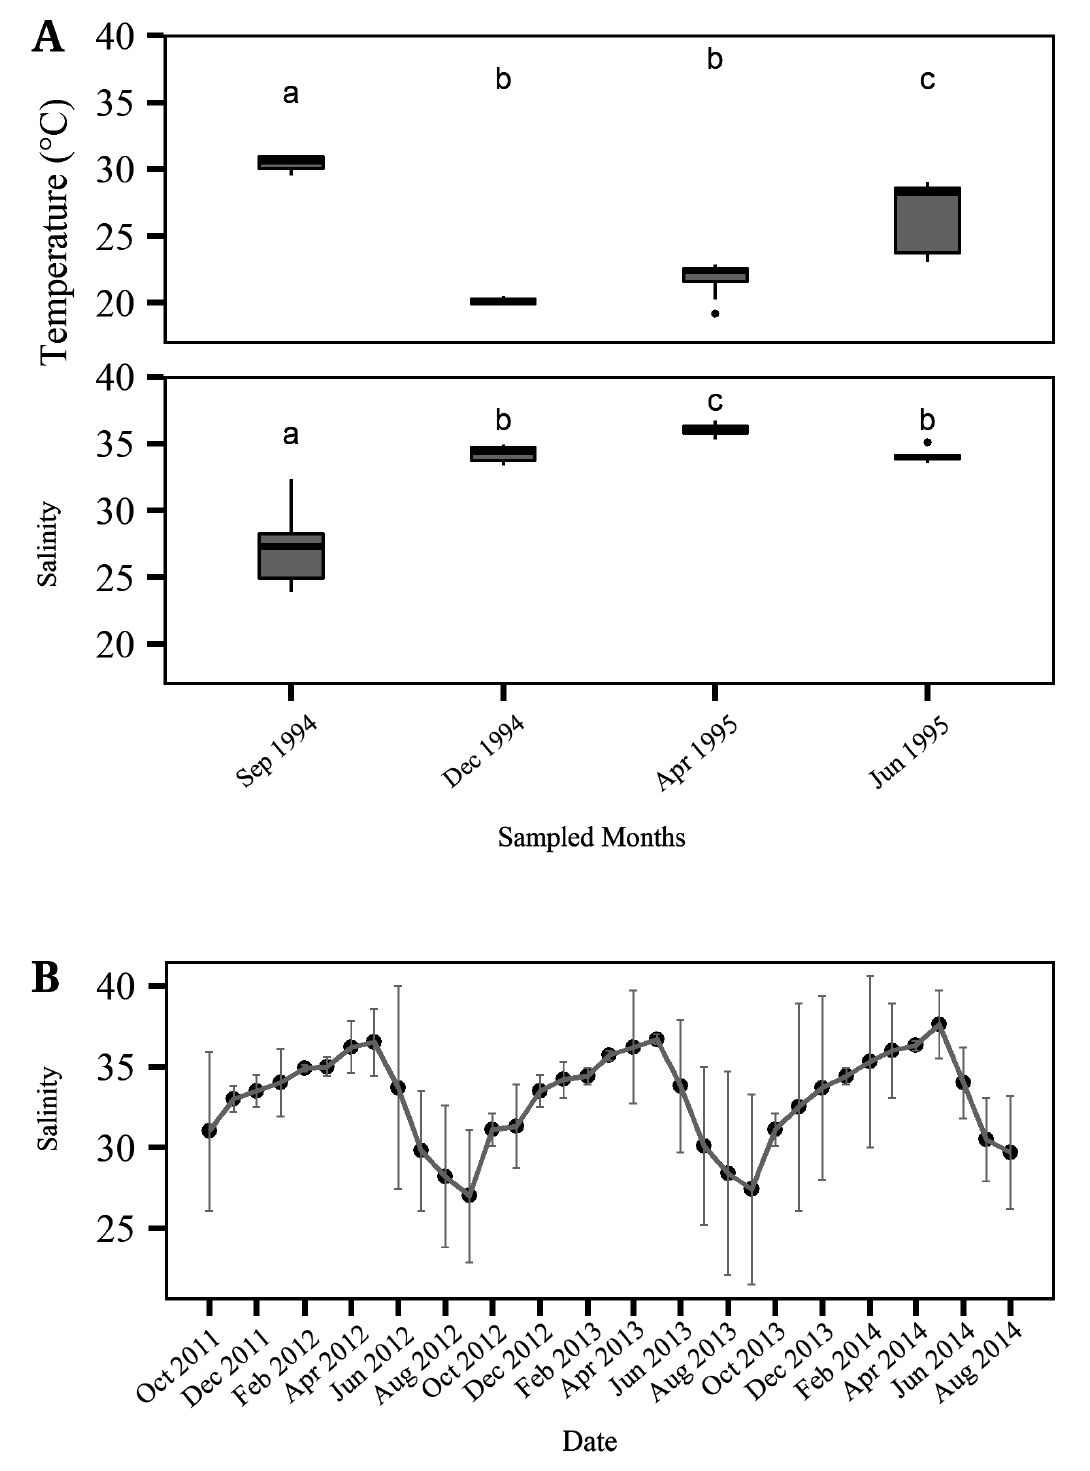
FIGURE 2 | A. Box plots showing temporal variations in temperature and salinity during the sampling period (1994–1995). Line: median; box: 25th to 75th percentiles; whiskers: minimum to maximum value range. Months with the same letters do not significantly differ using Dunn’s test. B. Monthly variability of salinity from October 2011 to August 2014, dots indicate the mean value and error bars the Standard